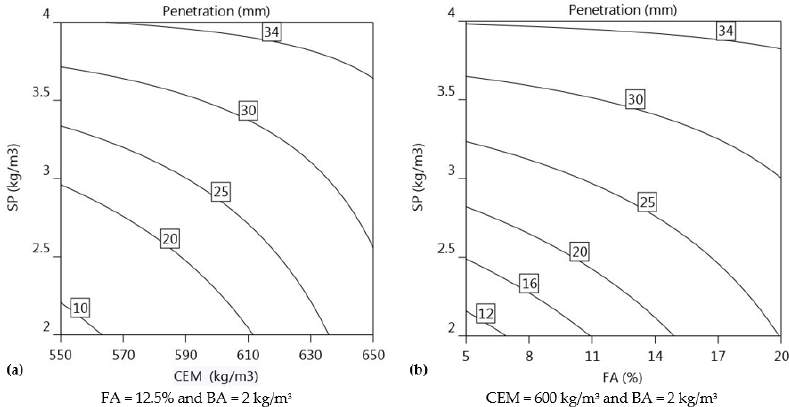
Figure 9. Isoresponse curves of cone penetration test: ( a ) SP versus CEM and ( b ) SP versus FA.